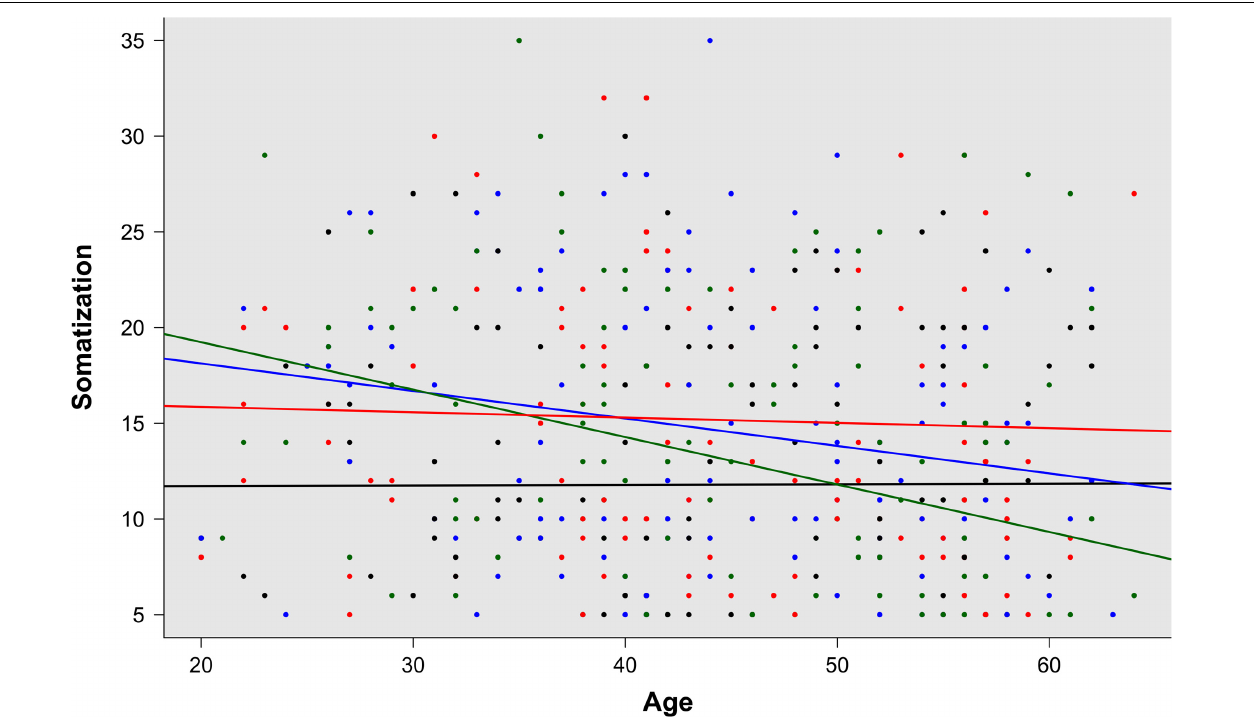
FIGURE 2 | Regression analysis for “occupation by sex” groups, male physicians (black), women physicians (green), male nurses (blue), and women nurses (red), according to somatization by age ( p =